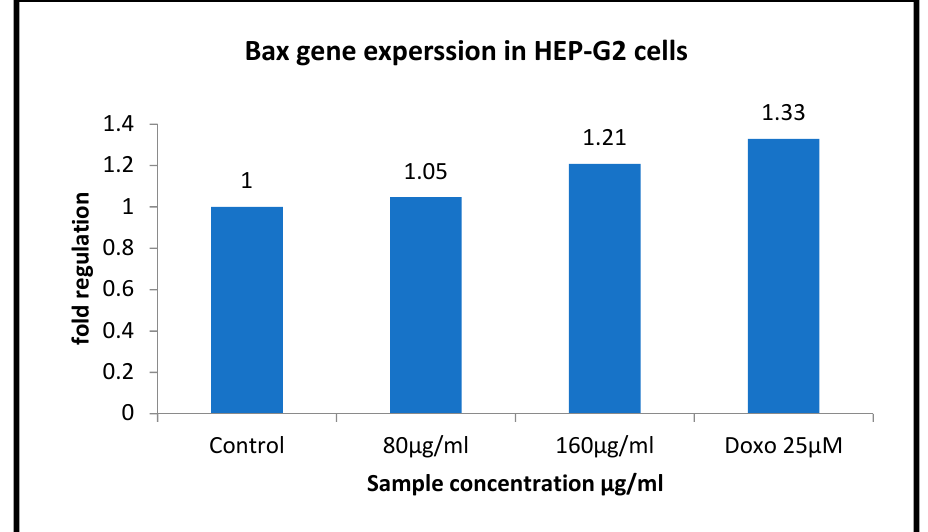
Figure 14. Graphical representation of BAX gene expression. The Ashwagandha treatment at different concentrations on the HepG2 cell line has shown significant downregulation of the BCL II gene. Concentrations of 80 µ g/mL and 160 µ g/mL showed downregulation of BCl2 gene expression to 0.71 and 0.65 in the HepG2 cell line, respectively. The positive control doxorubicin treatment at 25 µ M on the HepG2 cell line showed significant upregulation in BAX genes (to 1.33) and downregulation in BCL II genes (to 0.47) in the HepG2 cell line (Tables 5 and 6) and (Figures 15 and 16). Table 5. Relative expression of BAX gene treated with Ashwaganda in HepG2. HepG2 Sample Conc.